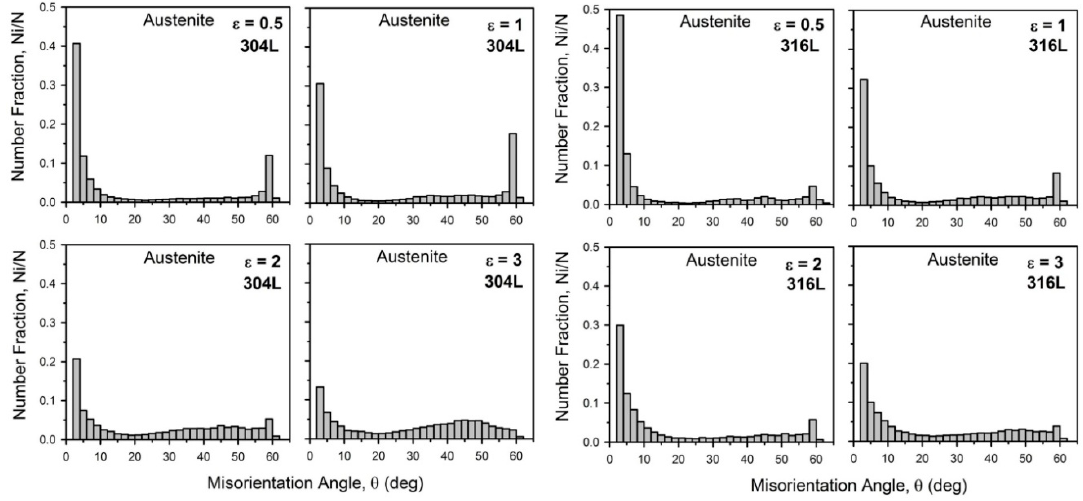
Figure 9. (Sub)grain boundary misorientation distributions evolved in austenite of 304L and 316L stainless steels subjected to rolling at 473 K to various total strains ( ε